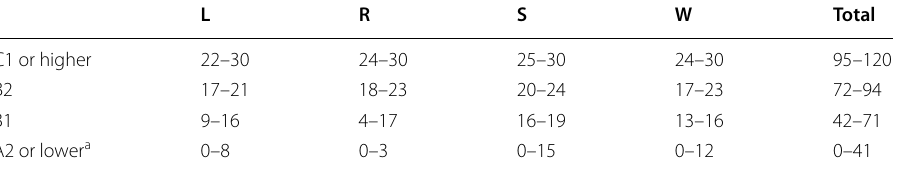
Table 3 Comparison table between TOEFL iBT scores and CEFR levels in Study